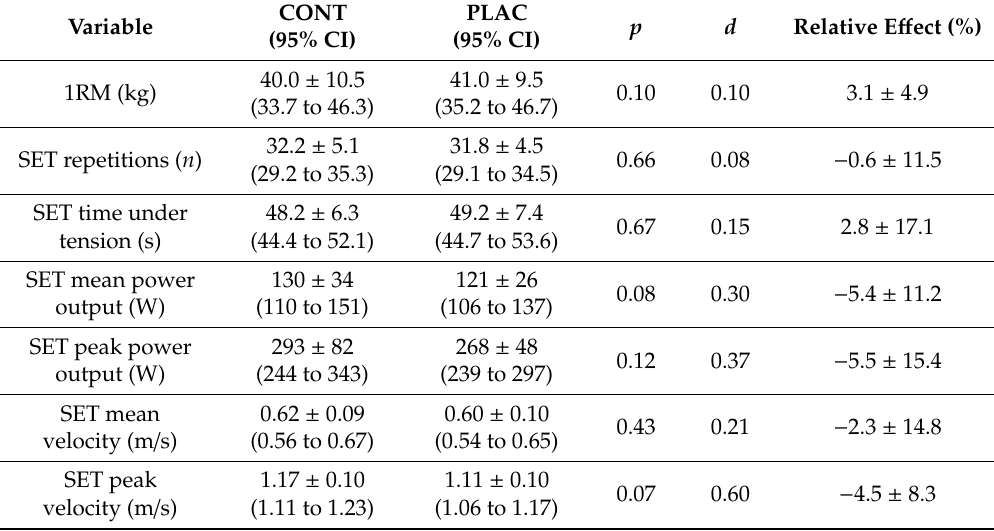
Table 2. Muscle performance variables for placebo (PLAC) and control (CONT)